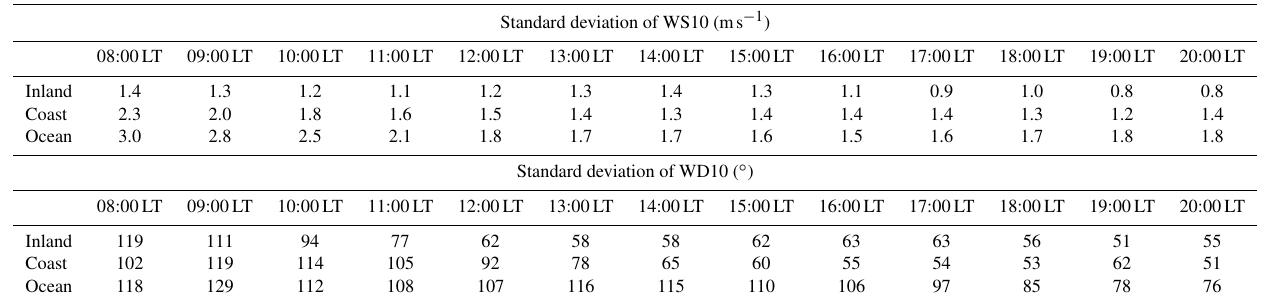
Figure 6. Spatial patterns of the development of the averaged events of pure sea breeze from 08:00 to 20:00LT. The colored contours indicate the magnitude of 10m wind speed (ms − 1 ), and the vectors show the wind direction. Table 3. Standard deviation of WS10 and WD10 of the simulated cases of pure sea